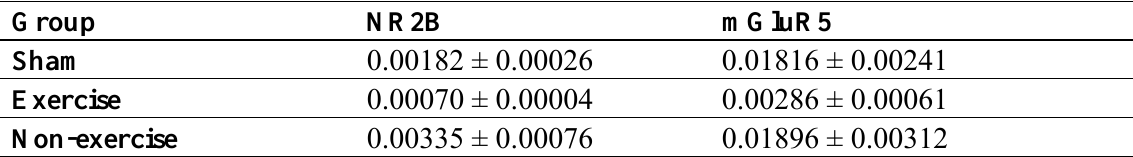
Table 3. Relative gene expression levels of NR2B and